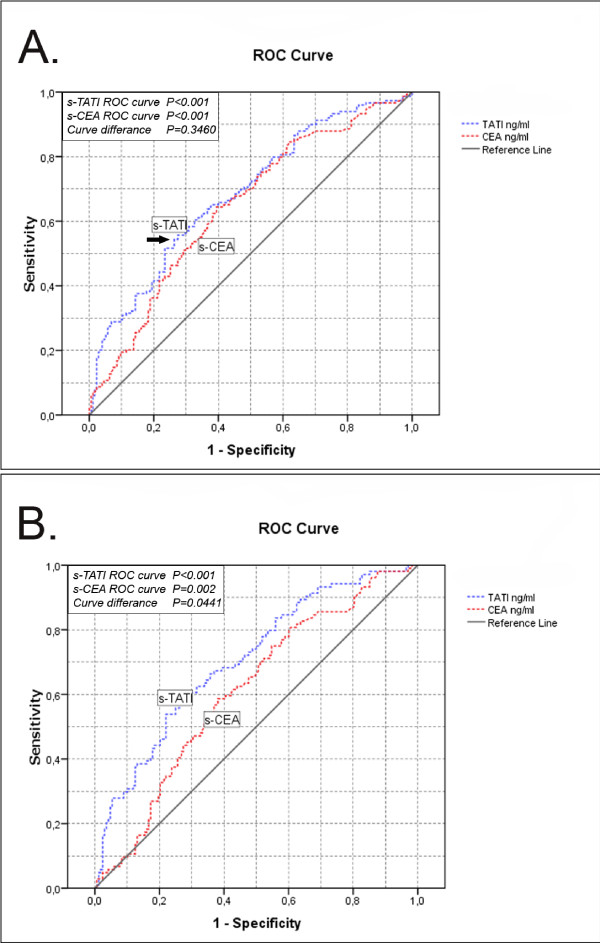
ROC curve analysis. ROC curve analysis calculated with the use of survival data (OS), showing AUC on s-TATI compared to s-CEA in all patients (A), curatively treated patients (B). Cut-off based on the point farthest to the northwest (black arrow) extracted from ROC curves data table (data table not shown).